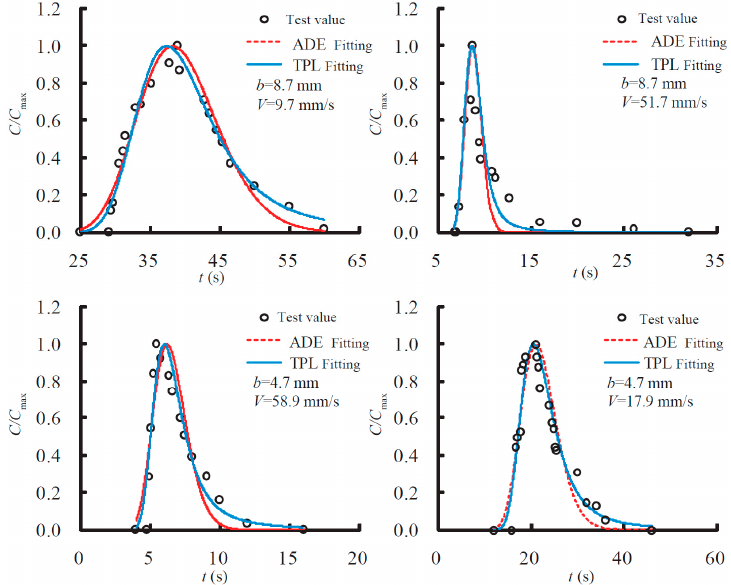
Figure 9. BTCs and fitting results in single fractures with smooth parallel plates ( x = 555 mm).